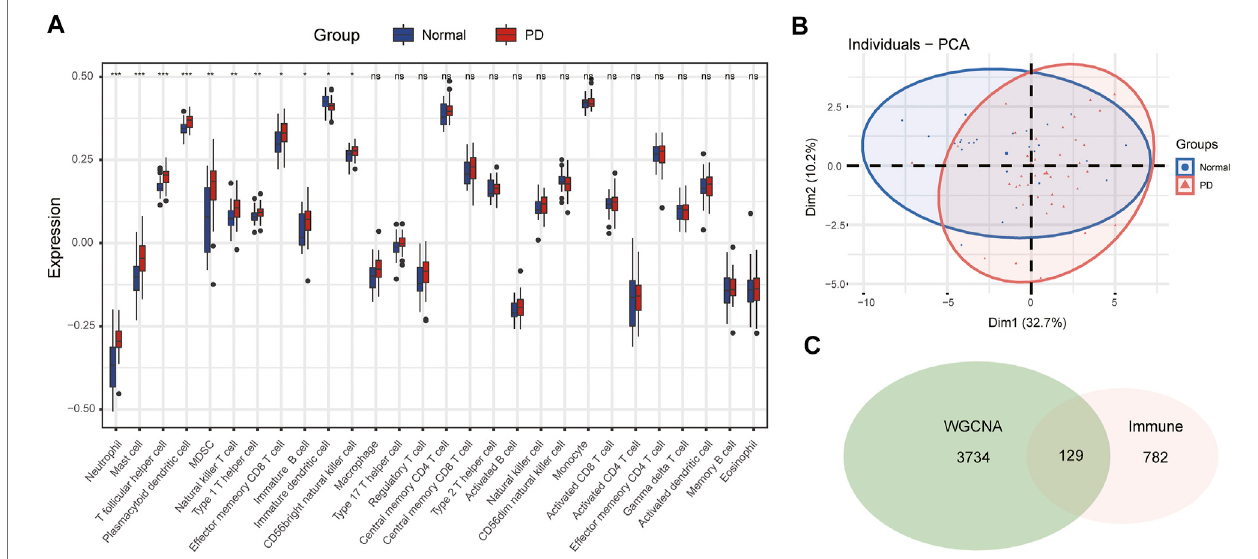
FIGURE4| Theimmunecellin fi ltrationanalysisofsubstantianigrabetweenPDpatientsandhealthycontrols. (A) Thelandscapeofimmunecellin fi ltrationinPDand healthy controls. There were eleven immune cells with signi fi cant difference (neutrophil, mast cell, T follicular helper cell, plasmacytoid dendritic cell, MDSC, natural killer T cell, type 1 helper cell, effector memory CD8 T cell, immature B cell, immature dendritic cell, and CD 56 bright natural killer cell). (B) Principal component analysis for immune cell in fi ltration in PD and healthy controls. (C) Venn diagram of genes screened via WGCNA and immune-related genes dataset. ns, p > 0.05, * p < 0.05, ** p < 0.01, *** p <